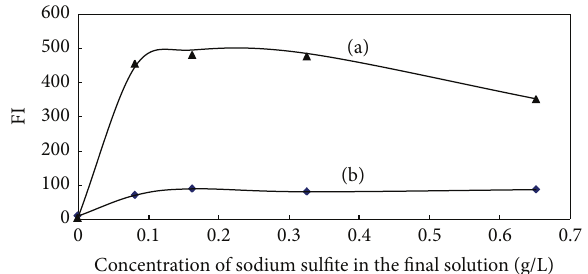
Figure 4: Effect of sodium sulfite concentration in the final solution on the reaction of OPA-NH 3 -sulfite ((a) 0.25 𝜇 mol/L, (b)